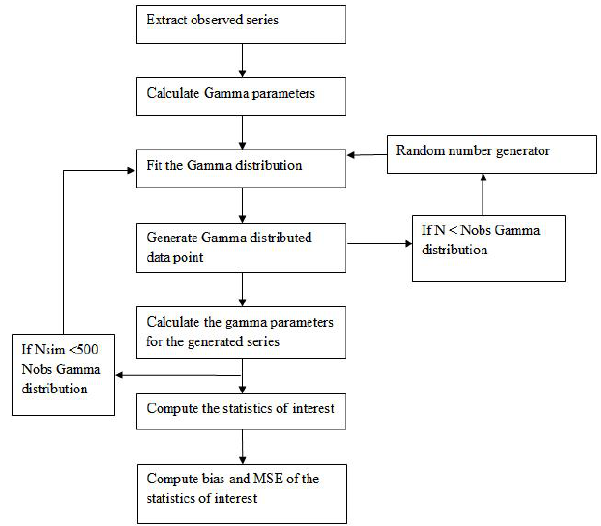
Fig. 2. Flowchart for data fitting, simulation and evaluation. Nobs – number of observations; Nsim – number of simulations; MSE – mean square